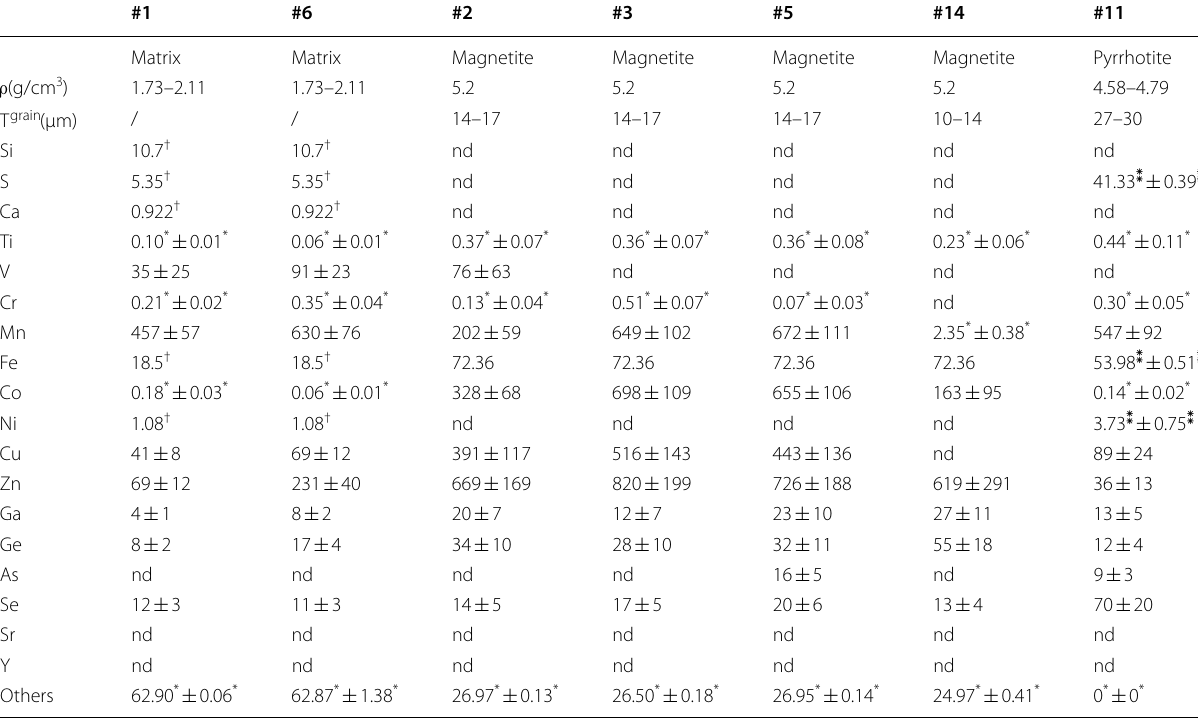
For the Fe concentration in magnetite it was preferred to use its stoichiometric value as the SEM–EDX quantification of O is less reliable. Data in ppm, except for the asterisk (*) representing data in wt%, the double asterisk ( ⁑ ) representing SEM–EDX data in wt% and the dagger (†) representing CI chondrite composition data from Lodders, 2010 in wt%. nd not =